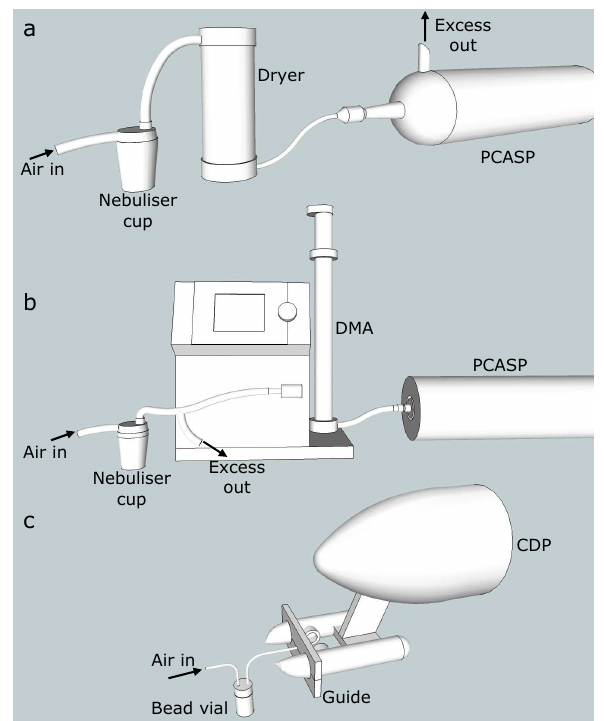
Fig. 2. Calibration setup for the PCASP and CDP OPCs. The PCASP is either calibrated using nebulised PSL spheres (a) or a DMA with nebulised DEHS oil aerosol (b) and the CDP is cali- brated with dry dispersed glass beads (c) . When used with the DMA the PCASP conical inlet is removed and the sample line is con- nected directly to the subsampler. During calibration of the CDP a guide attaches to the instrument arms to direct the sample into the sample